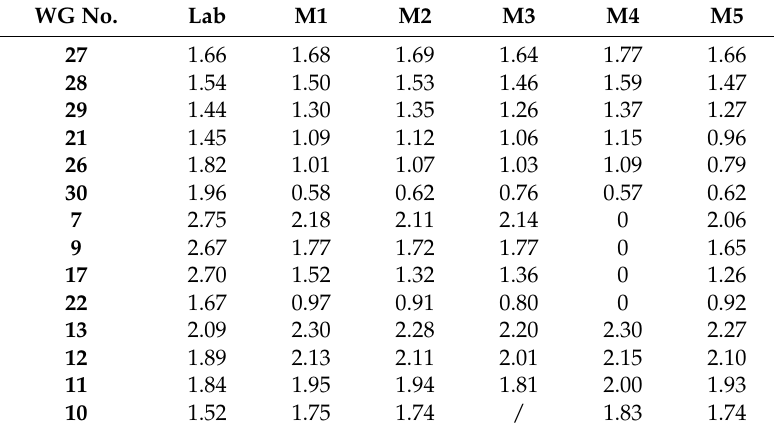
Table 4. The p 250 values acting on the sloping plate, the crown wall and the bottom part of the reservoir (uplift pressures) in kPa. See Figure 5 for the gauge locations. WG No. Lab M1 M2